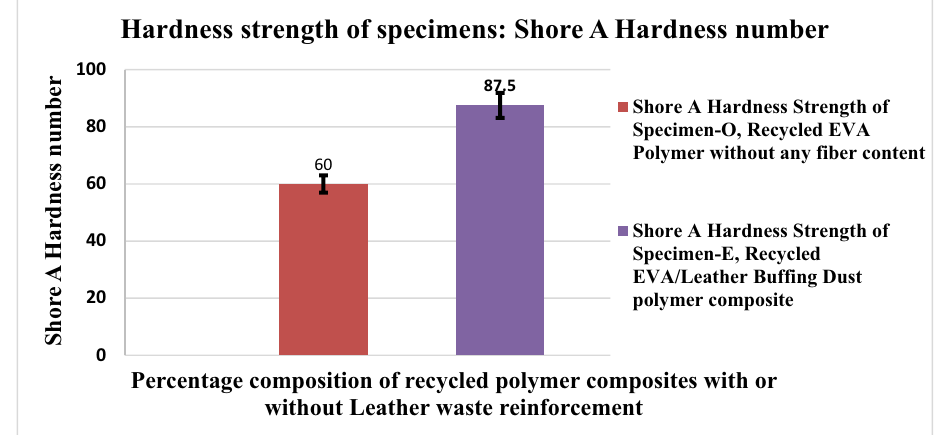
Figure 42: Comparison of hardness ( shore A ) of recycled EVA polymer composites with or without leather bu ffi ng dust.